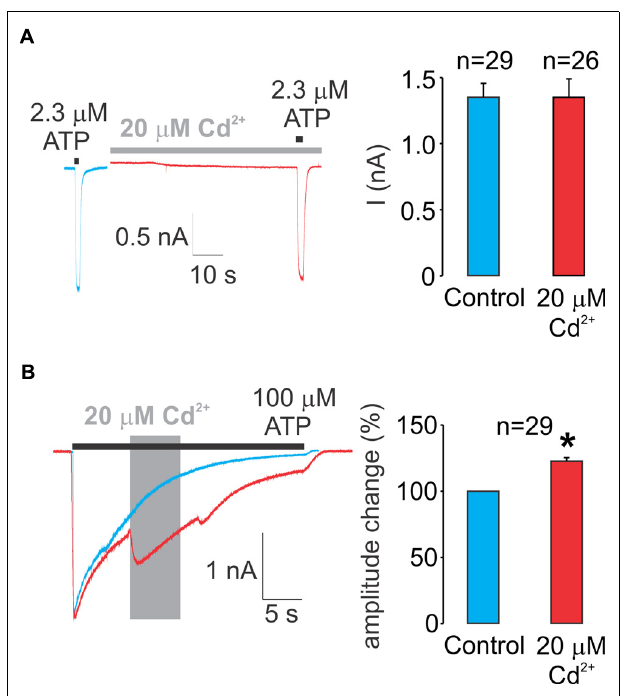
FIGURE 2 | Effects of cadmium onWT rP2X4R gating. (A) A lack of pre-application during 1 min and a subsequent 2-s co-application of 20 μ M cadmium on ATP-induced peak current response. 2.3 μ M ATP (applied for 2 s) is the EC 50 dose for theWT receptor. (B) Effect of the application of 20 μ M cadmium ion on 100 μ M ATP-induced sustained current. Cadmium was applied within 50 ± 10% desensitization decay (gray area) and significantly amplified the current amplitude, on average 22 ± 3%. Left panels show representative traces; control traces are blue, and traces with cadmium treatment are red. Right panels illustrate mean ± SEM values, with n shown above bars; * illustrates significant difference, P < 0.01.To avoid the impact of desensitization and the subsequent internalization on the current amplitude and patterns, control, and experimental traces were obtained in separate cells during a single ATP